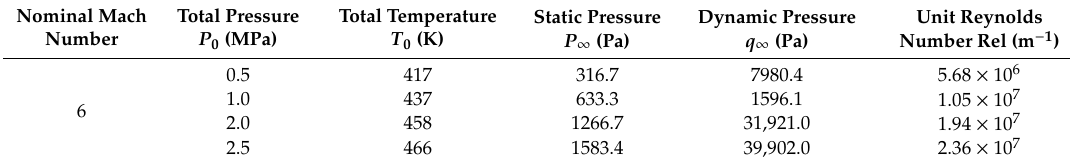
Figure 11. The test facility and Schlieren photo for sensor prototypes.( a ) The test facility;( b ) Schlieren photo. Table 3. The detailed flow field parameters of the wind tunnel used for sensor validation.